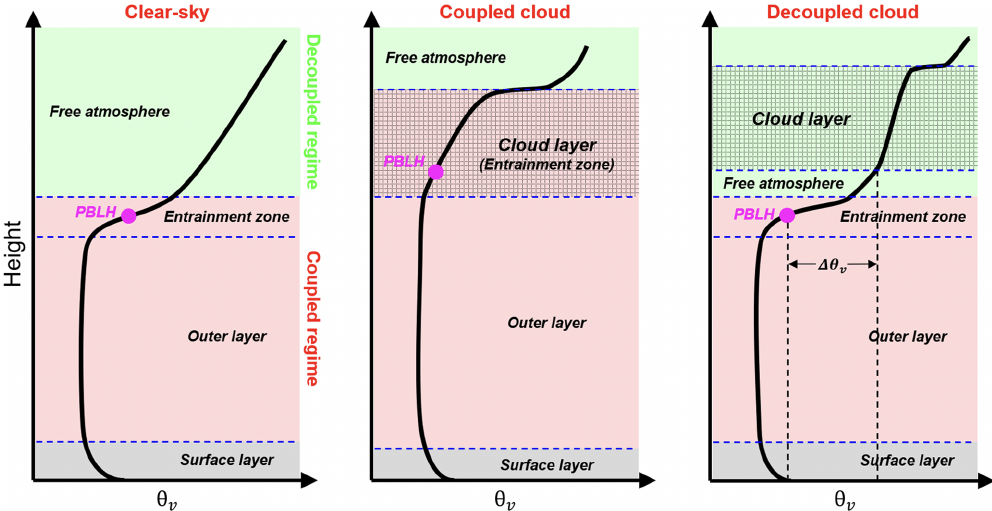
Figure 1. Idealized vertical profiles of virtual potential temperature ( θ v ) under the clear sky, coupled cloud, and decoupled cloud over land. The surface layer, outer layer entrainment zone, and free atmosphere are divided by the dashed blue lines. The cloudy layer is marked as the shaded area, and PBLH is marked as the pink point. Red and green zones indicate the coupled and decoupled regime, respectively. Elements (e.g., turbulence, heat fluxes, cloud) in the coupled regime are directly affected by the PBL processes, while these elements are not directly affected by the PBL processes in the decoupled regime. For the coupled cases, the cloud base is below the capping inversion of entrainment zone. For the decoupled cases, the cloud base is above the capping